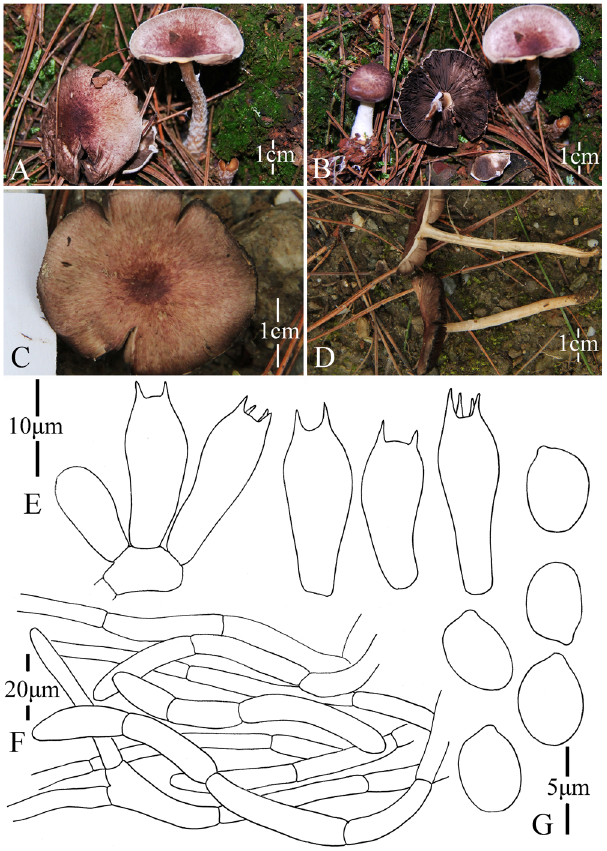
Figure 17. Morphology of Agaricus pseudopurpurellus ( ZRL2014063 , holotype), ( A – D ): Basidiome in the field ( A , B : ZRL2012012 ; ( C , D ): ZRL2014063 ), ( E ): Basidia ( F ): Pileipellis hyphae, and ( G ):